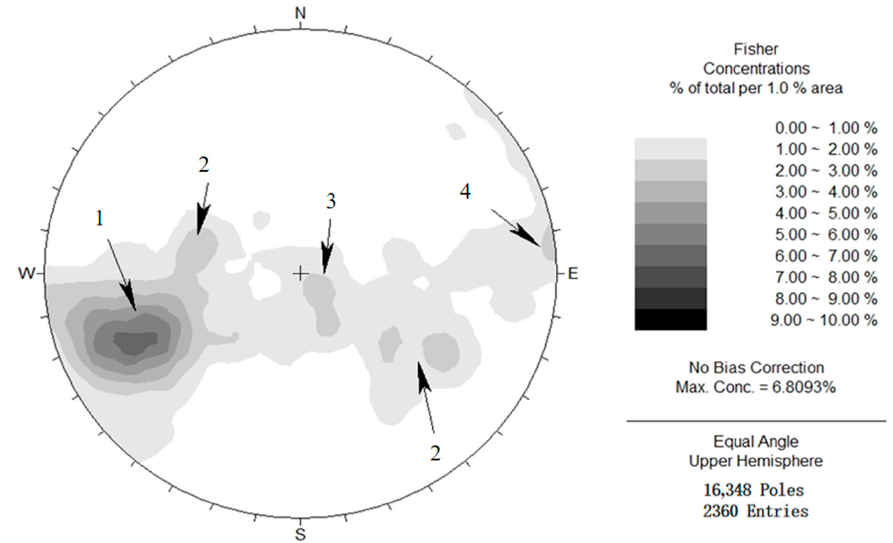
Figure 6. Iso-density map of fissure poles in the dam site area (excluding layer fissures). There are eight main strata in the landslide slope. Depending on the rock formation and the terrain, we divided it into different parts with color lines, and the lithology is shown in Figure 7. Figure 7. The lithology of the slope of the typical dumping body on the left bank.